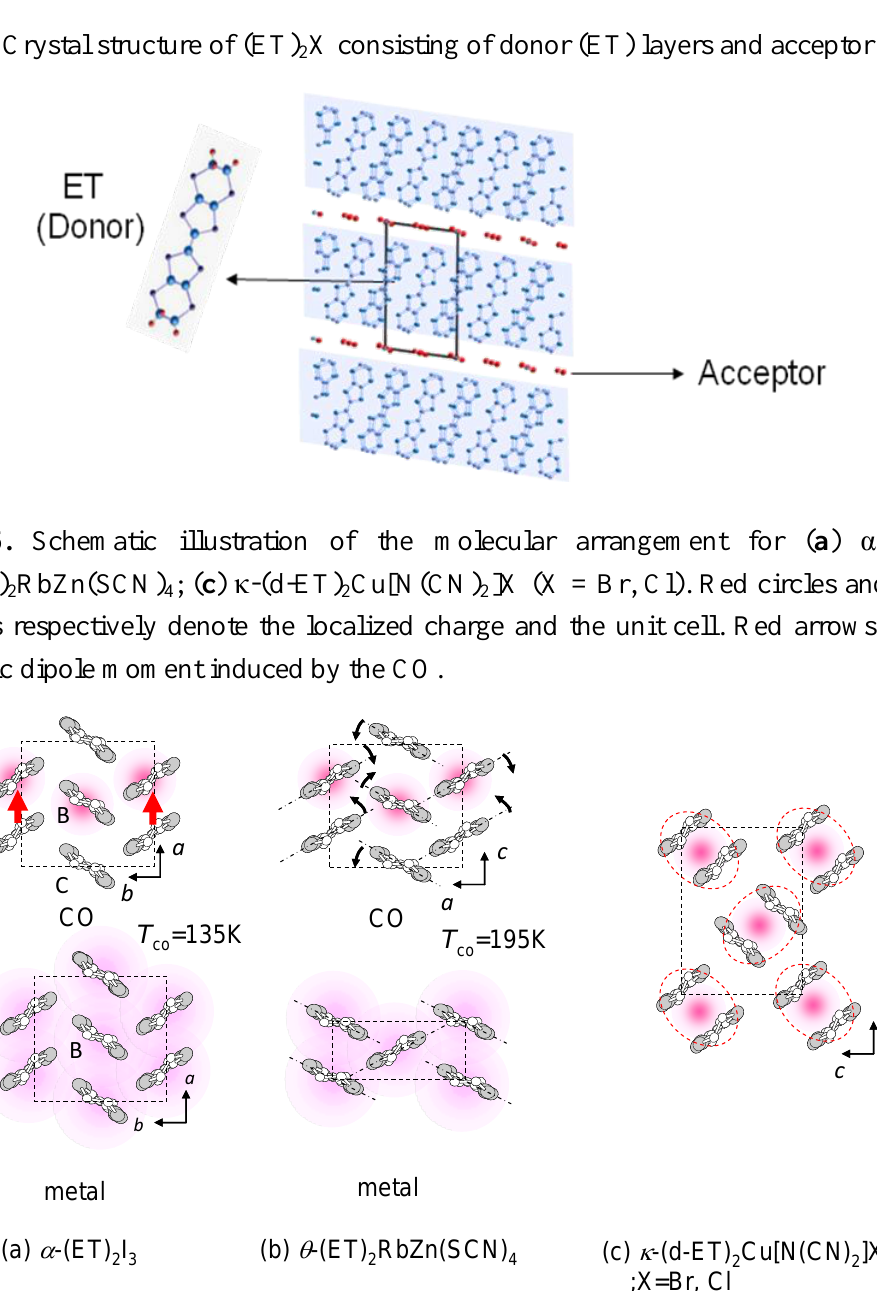
Figure 4. Crystal structure of (ET)